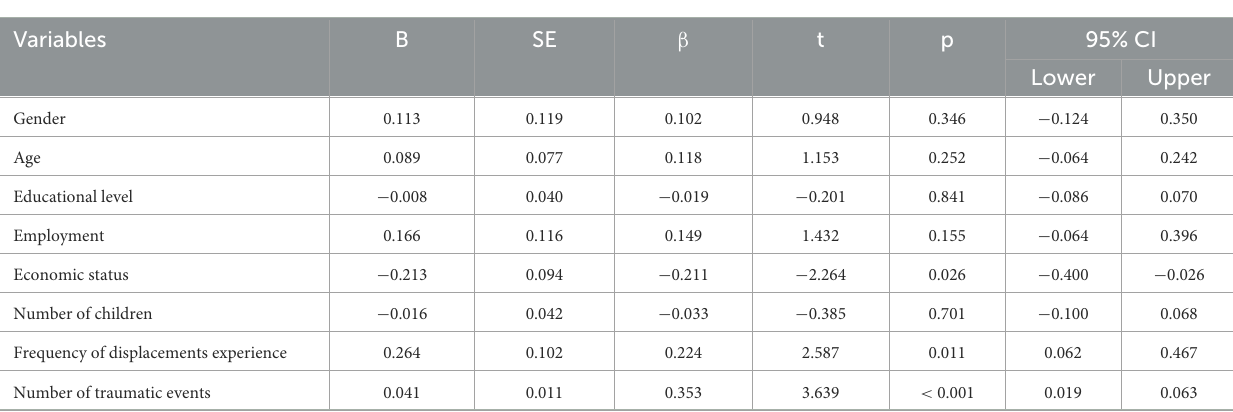
TABLE 2 Predictors of posttraumatic stress symptoms